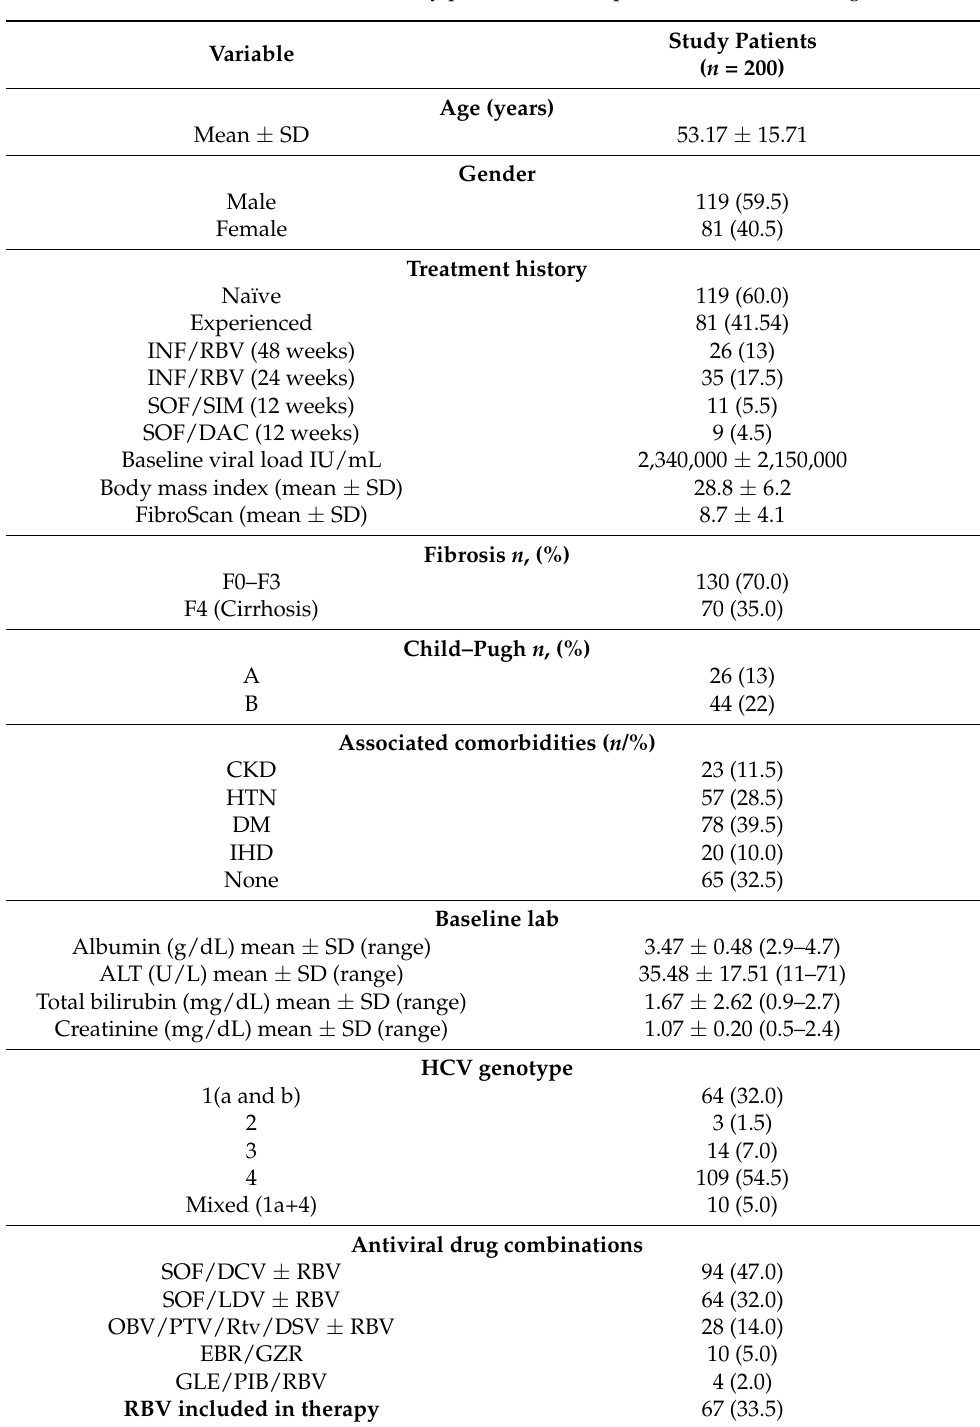
Table 1. Baseline characteristics of the study patients and the prescribed antiviral